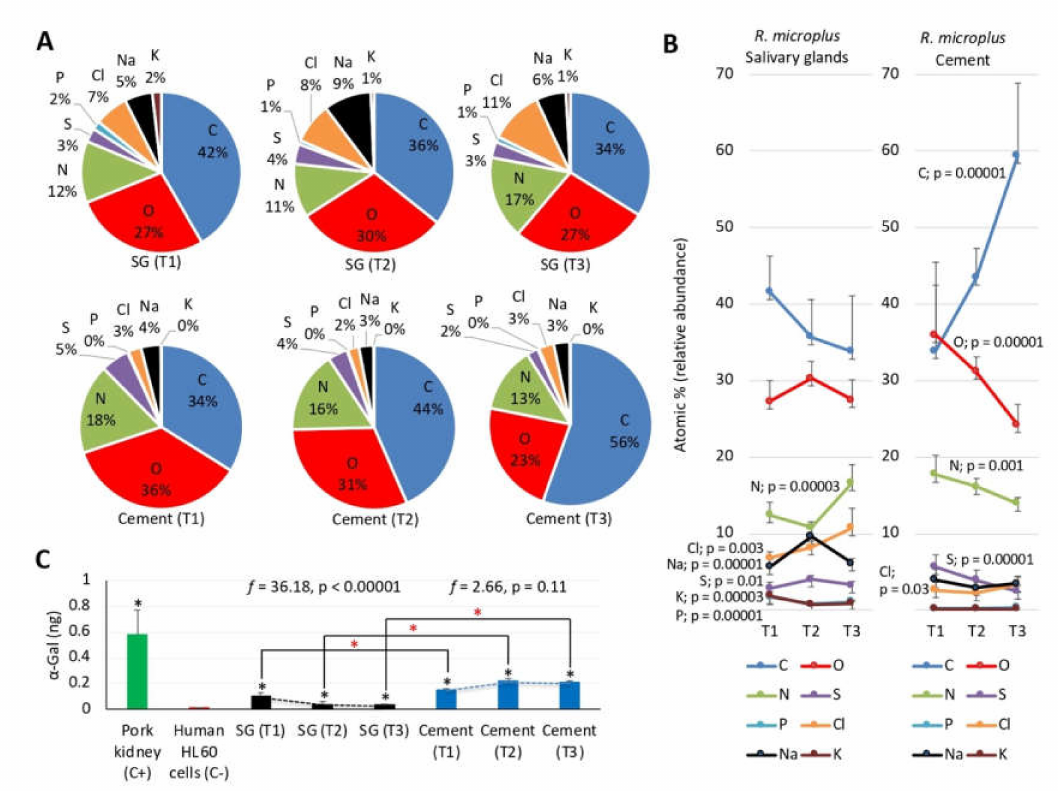
Figure 8. Composition of chemical elements in tick salivary glands and cement. Chemical elements were characterized by SEM combined with EDS analysis in samples from tick salivary glands (SG) and cement. ( A ) Representation (%) of the chemical elements at di ff erent feeding stages (T1–T3). ( B ) Changes in the representation (%) of the chemical elements at di ff erent feeding stages (T1–T3). The composition of chemical elements was compared at di ff erent time points by One-way ANOVA test (https: // www.socscistatistics.com / tests / anova / default2.aspx; p < 0.05, n = 2–4 biological replicates). ( C ) Characterization of α -Gal content in tick SG and cement protein extracts and in comparison with human promyelocytic leukemia HL60 cells (ATCC CCL-240) and pork ( Sus scrofa ) kidney as negative and positive controls, respectively. A calibration curve with 0.0–1.0 ng α -Gal and O.D. values at 450 nm was constructed using Microsoft Excel for Mac (v. 16.26) to convert ELISA reader values to α -Gal content per sample ( R 2 = 0.913). The results (average + S.D. of α -Gal / 1 µ g protein) were compared between pork kidney positive control, salivary gland or cement samples and HL60 cells